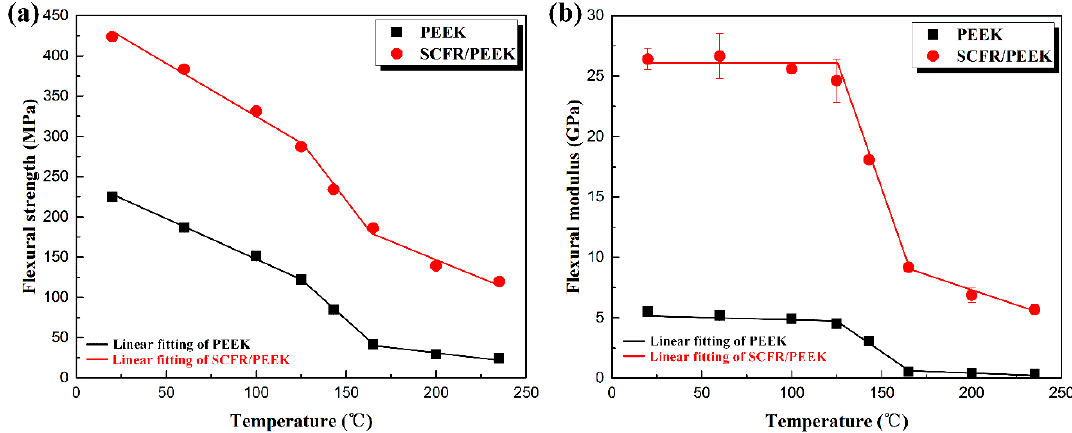
Figure 6. Relationship between flexural properties and temperature of PEEK and SCFR/PEEK: ( a ) Flexural strength vs. temperature; ( b ) Flexural modulus vs. temperature.